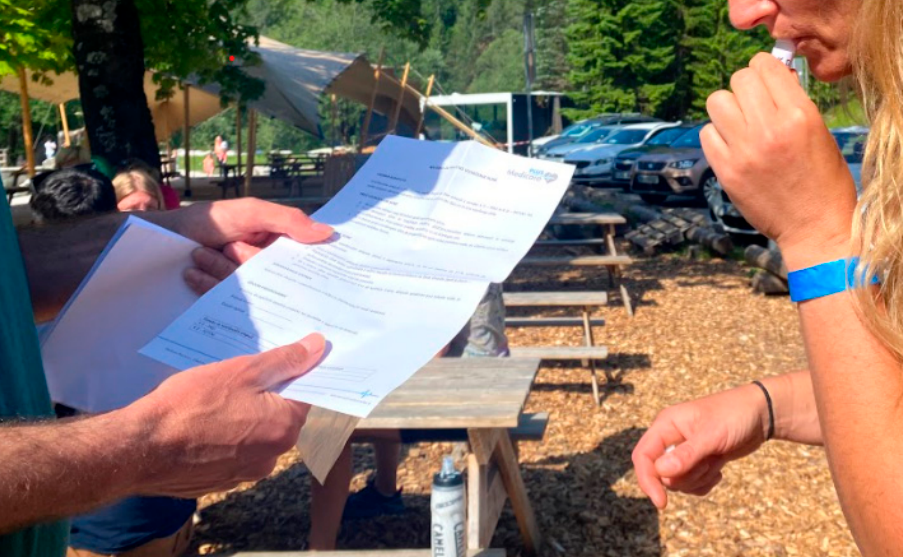
Figure 4. Taking the saliva sample of participant.